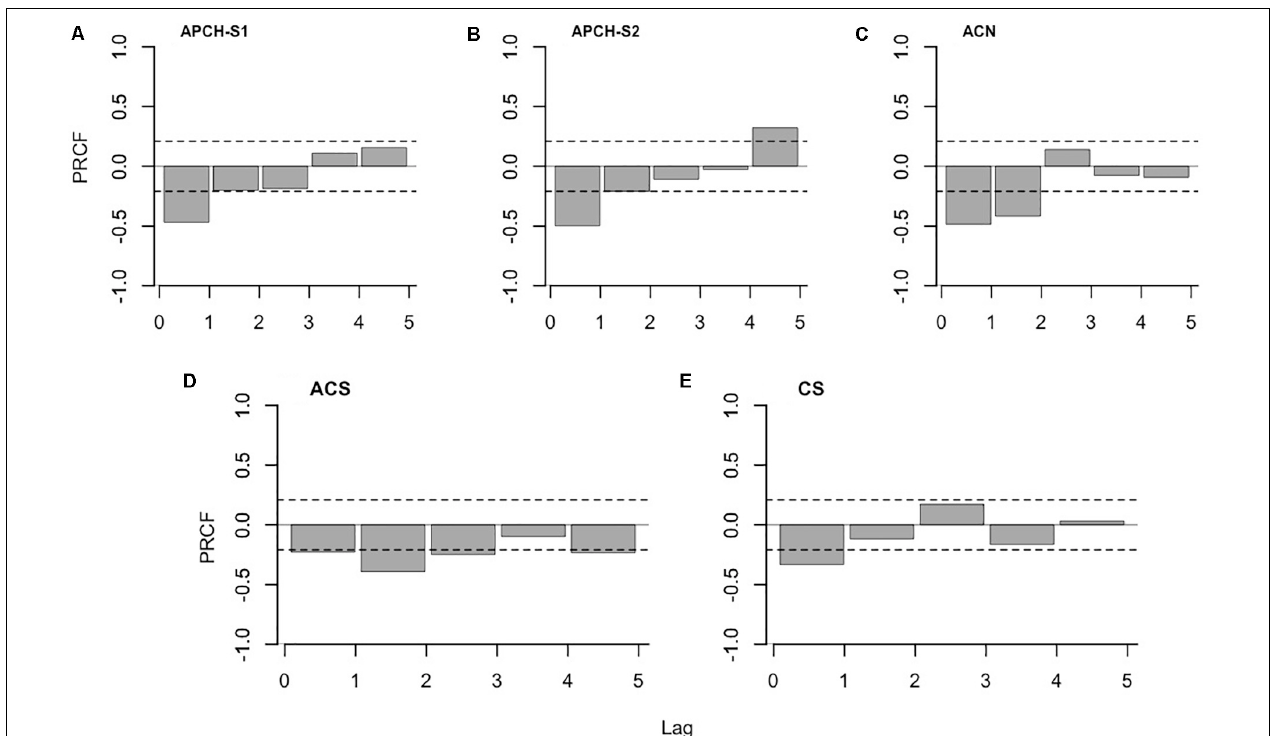
FIGURE 3 | Partial rate correlation function (PRCF) of the per capita population growth rate ( R t , y -axis) and the biomass at different time lags ( x -axis). The analysis diagnoses the relative contribution of the population feedback at a lag of i ( i = 0,1,2,3,4,5) (endogenous effect) for the determination of R t . (A) Anchovy population of southern Peru and northern Chile (APCH-S1). (B) Anchovy population of southern Peru and northern Chile (APCH-S2). (C) Anchovy population of central-northern Chile (ACN). (D) Anchovy population of central-southern Chile (ACS), and (E) the common sardine (CS) population of central-southern Chile (the dashed line indicates significance at p <